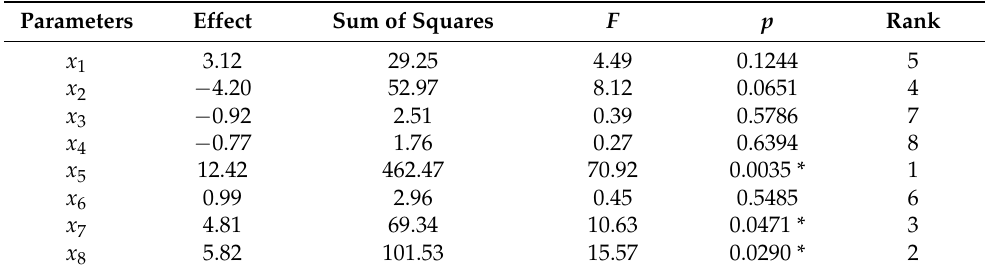
Table 5. Significance ranking of contact parameters.